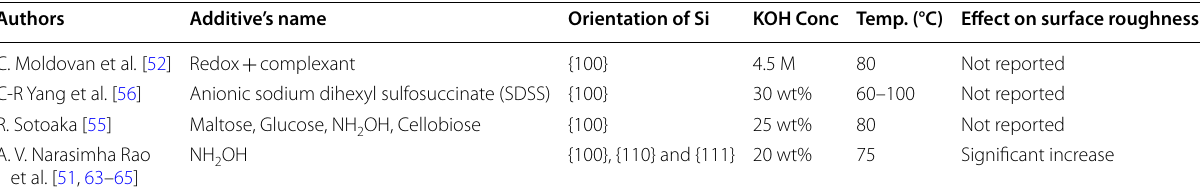
Table 7 The effect of various kinds of additives on the undercutting at convex corners in KOH solution